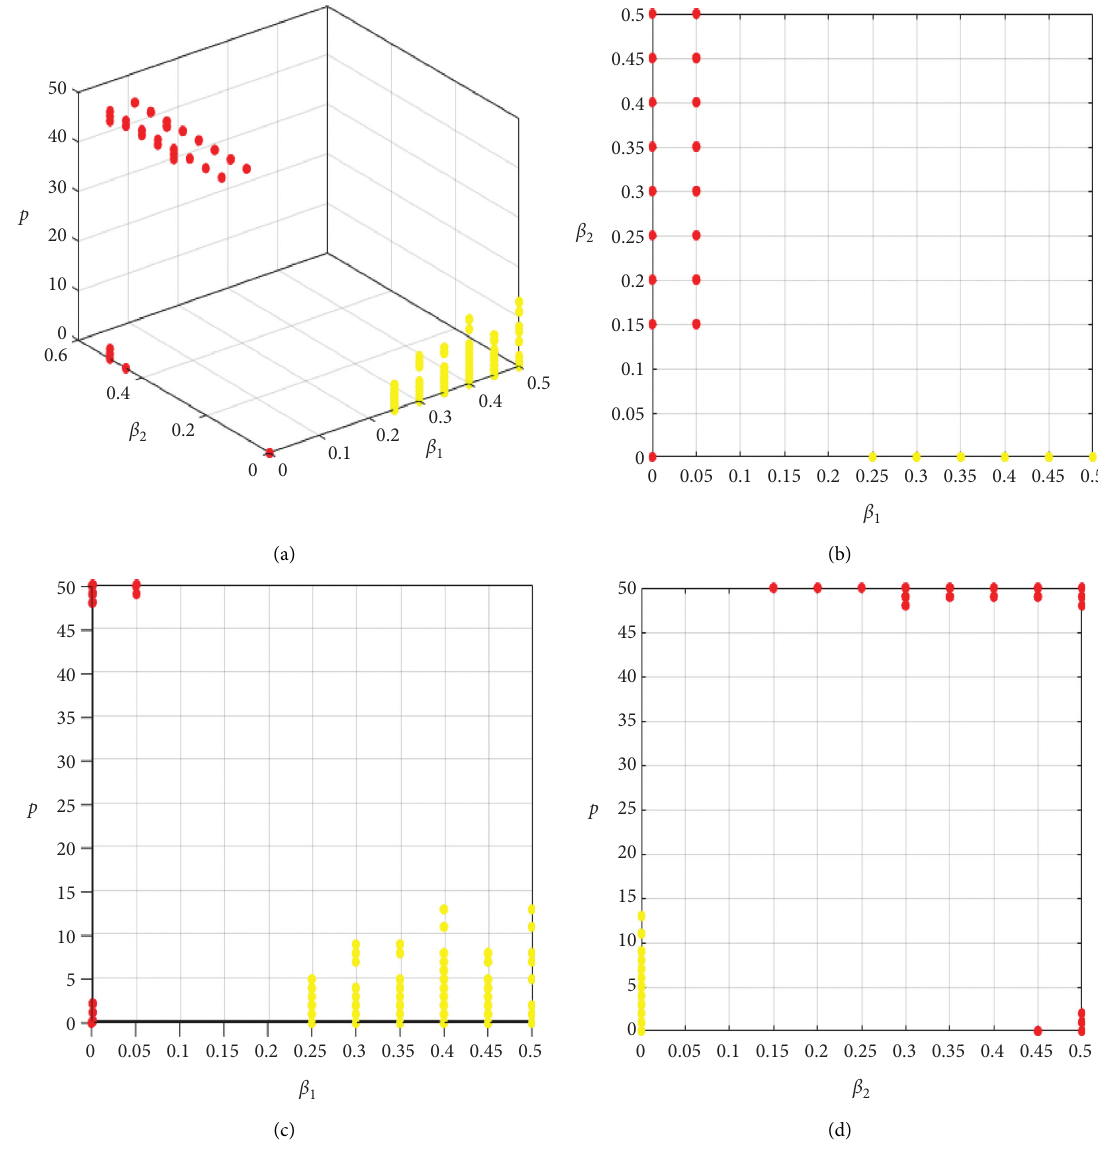
Figure 9: Pareto solutions at period one. (a) The stereogram of period one, (b) top view of the stereogram, (c) left view of the stereogram, and (d) right view of the Formula (18) is the delay strategy equations of the system. Compared with the previous system model, formula (19) adds the difference between the forecast value of the next period and the current period value as the adjustment